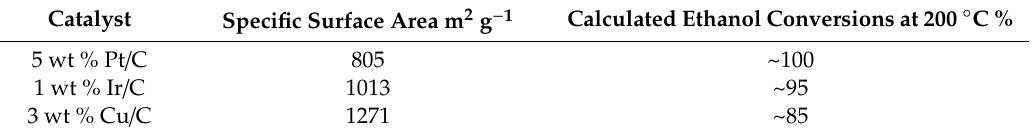
Table 2. Specific surface areas and ethanol conversions of the different C-supported catalysts.